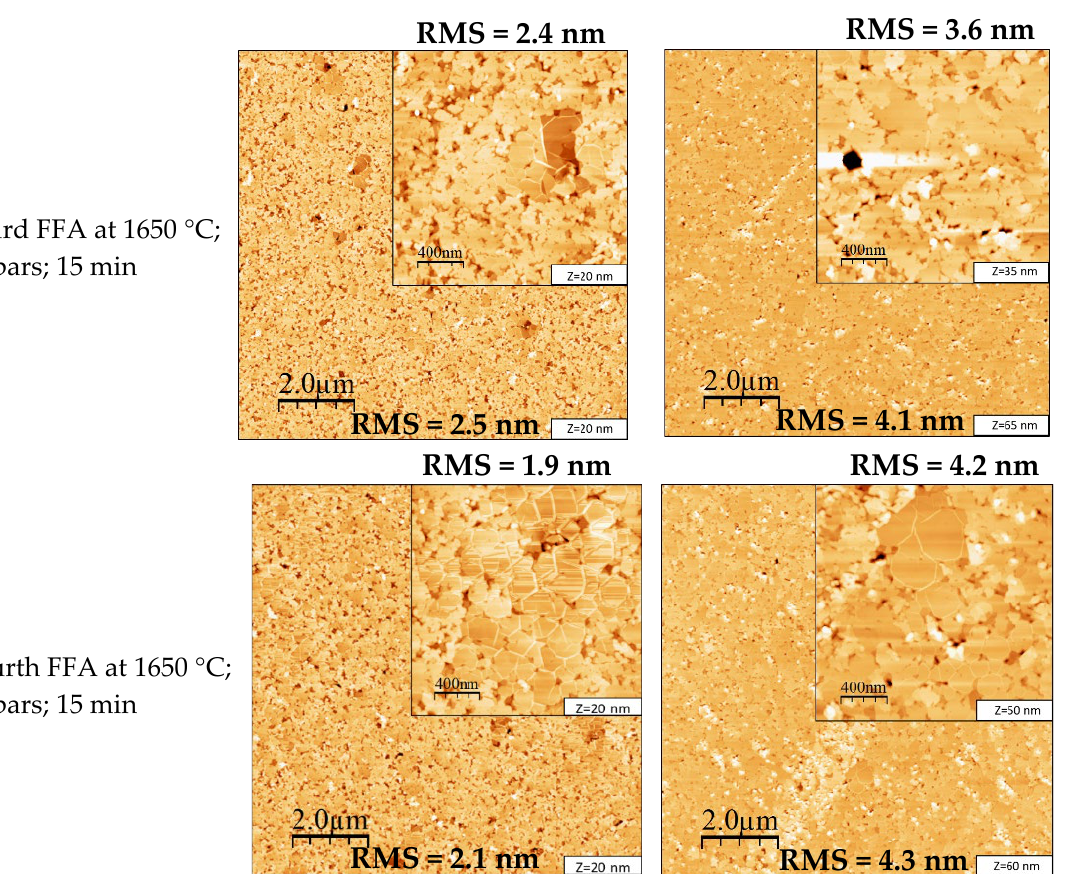
Figure 3. Atomic force microscopy images of (10 × 10) µ m 2 of samples A and B, i.e., 50 and 100 nm of AlN grown on 3 nm h-BN, respectively: ( a ) without postgrowth annealing, ( b ) with first annealing at 1450 ◦ C, ( c ) with second annealing at 1550 ◦ C, ( d ) with third annealing at 1650 ◦ C, and ( e ) with fourth annealing at 1650 ◦ C. The insets show 2 × 2 µ m 2 scan images. The term Z represents the vertical scale and the variation in height in the AFM images, and its value is reported at the bottom right hand side of each image.